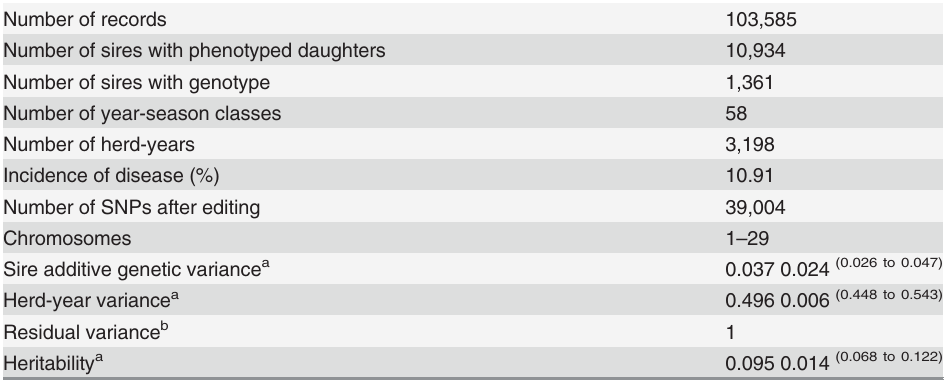
Table 1. Data summary and variance components and heritability estimates using single-step genomic-BLUP